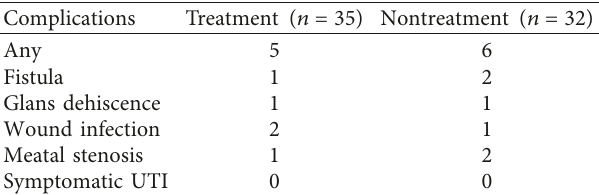
Table 3: Postoperative complications and symptomatic